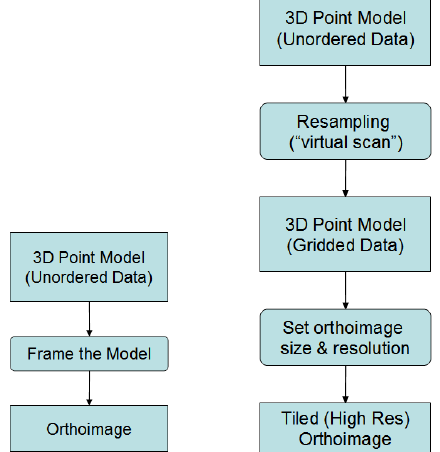
Figure 2. Ortoimage production workflow: Left - Cyclone (Leica Geosystems): low control on orthoimage resolution; Right - JRC Reconstructor (Gexcel): best orthoimage resolution, related to geometric